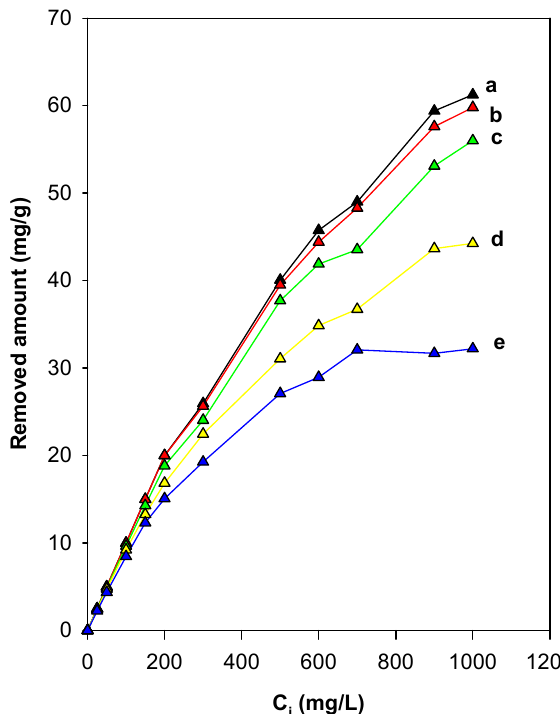
Figure 11. Effect of preheated temperatures of C16Mag-80 on the efficiency of eosin removal: ( a ) RT, ( b ) 100 °C, ( c ) 200 °C, ( d ) 215 °C, and ( e ) 250 °C.